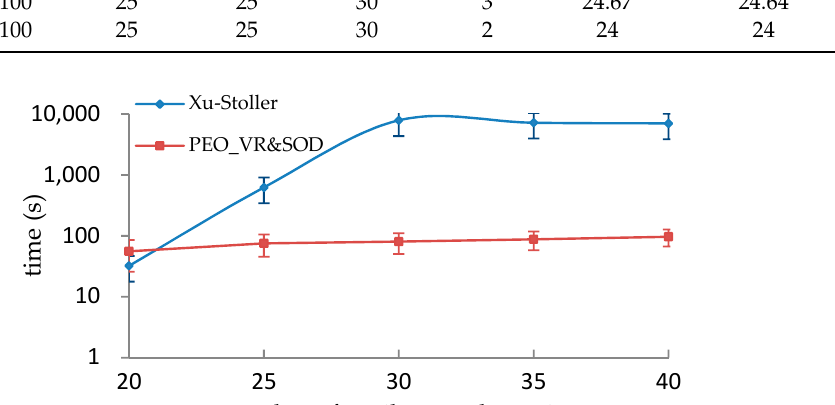
Figure 5. Comparison of time with Xu-Stoller for different numbers of attribute-value pairs.